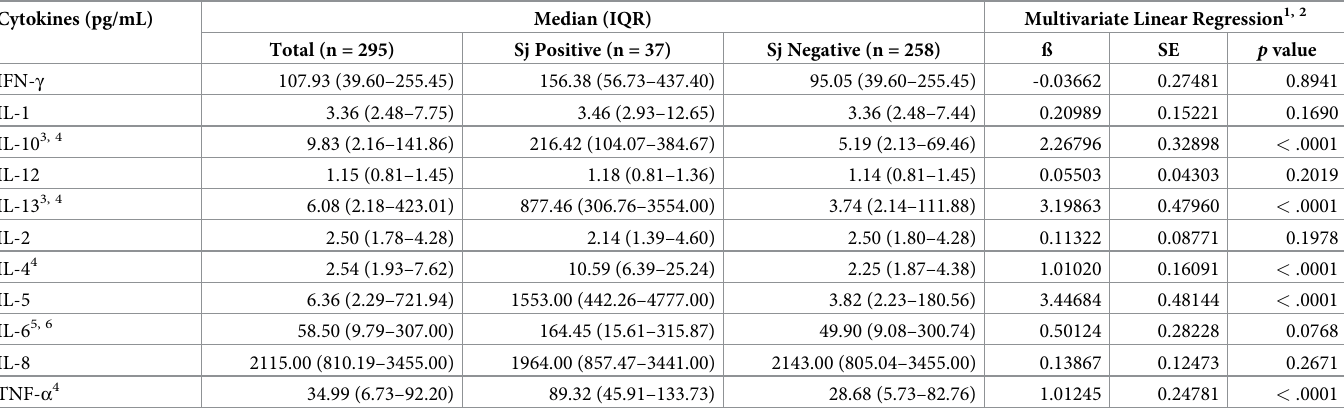
Table 3. Association between S . japonicum infection and SWAP-stimulated cytokines. Cytokines (pg/mL)